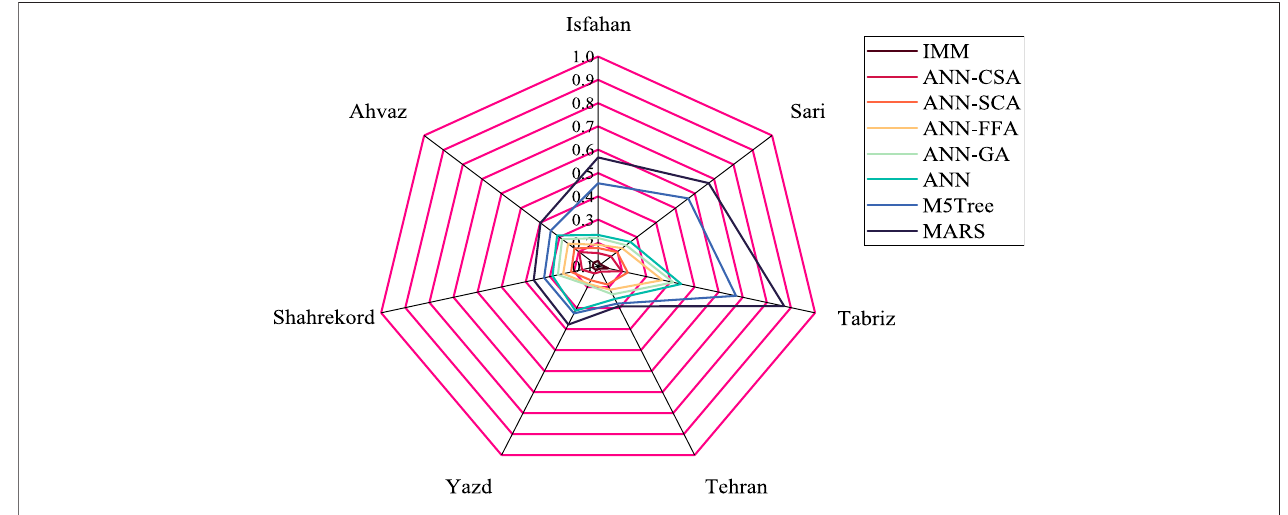
FIGURE 4 | Radar charts for comparing the models using CRMSE.